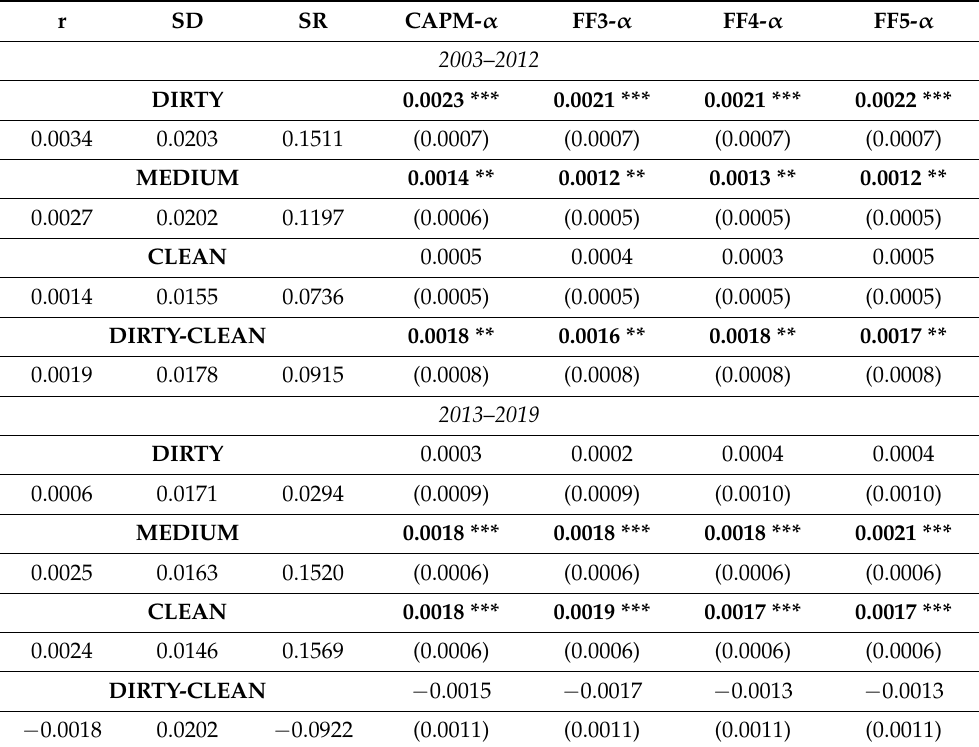
Table 2. Alpha coefficient and basic statistics for the sub-periods 2003–2012 and